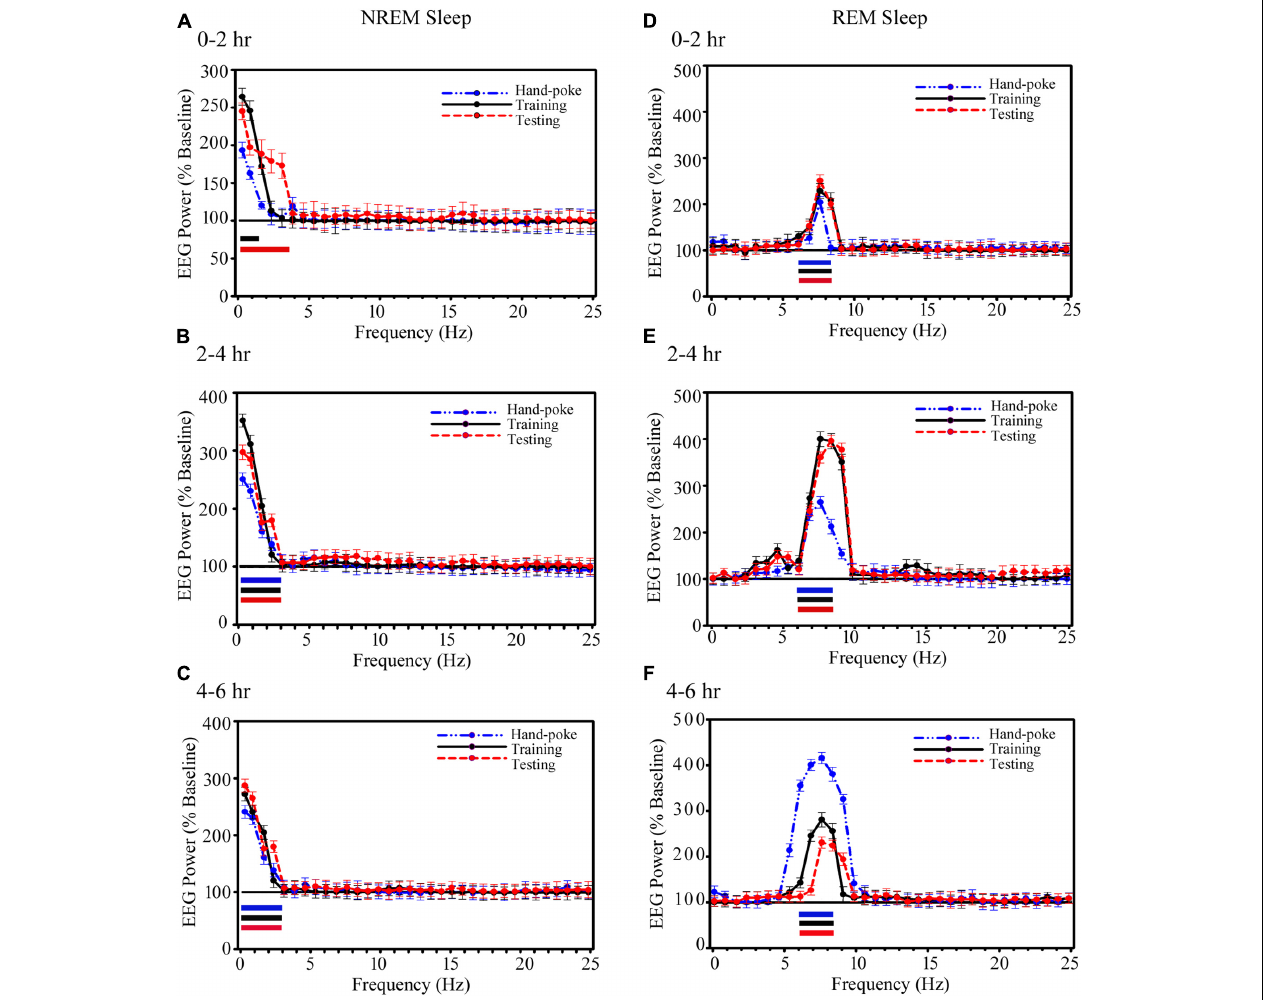
FIGURE 6 | Changes in the amygdalar SWA (0.1–4.5 Hz) during NREM sleep and theta waves (6–8.25 Hz) during REM sleep after hand-poke training, appetitive-conditioned training, and testing. SWA significantly increased during (A) 0–2 h (B) 2–4 h and (C) 4–6 h after hand-poke training, appetitive-conditioned training, and testing. Similarly, theta waves also significantly change during (D) 0–2 h (E) 2–4 h and (F) 4–6 h after hand-poke training, appetitive-conditioned training, and testing. Three different colored bars above abscissa: Blue colored bar ( ) represent significant changes on hand-poke training; black colored bar ( ) represents significant changes on appetitive-conditioned training, and red colored bar ( ) represents significant changes on the appetitive-conditioned testing day compared to the baseline day. The thickness of the colored bars above abscissa: Thick bar ( ) represents Bonferroni corrected p < 0.001; thin bar ( ) represents Bonferroni corrected p <